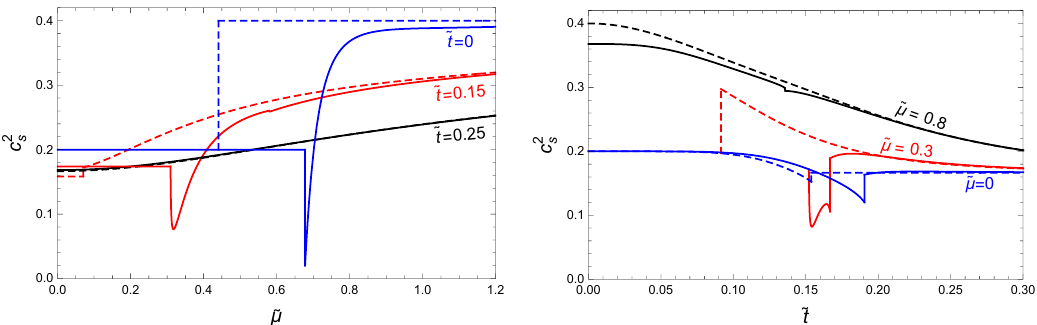
Figure 5 . Speed of sound (squared) in units of the speed of light as a function of ~ (cid:22) at three di(cid:11)erent temperatures (left panel) and as a function of ~ t at three di(cid:11)erent chemical potentials (right panel) for a mass parameter ~ (cid:11) = 0 : 04. The dashed lines are the corresponding results in the chiral limit ~ (cid:11) = 0. Here only the stable branches of the solutions are shown and discontinuities correspond to phase